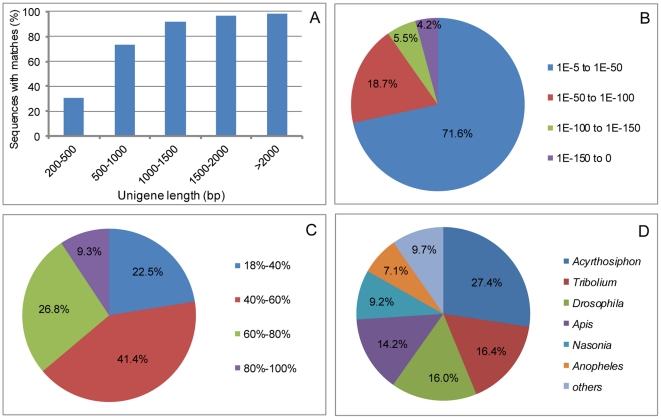
Analysis of Illumina sequences in the NR database.A. Proportion of sequences with matches; B. E-value distribution; C. Similarity distribution; D Species distribution.